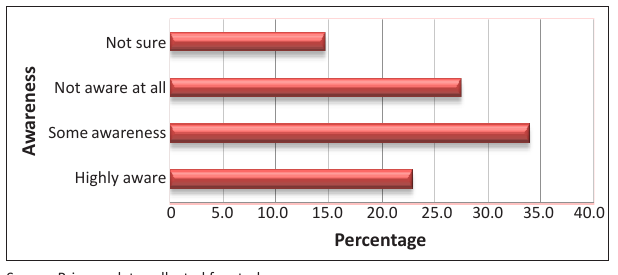
FIGURE 7: Awareness of Zimbabwean Disaster Management Policy.